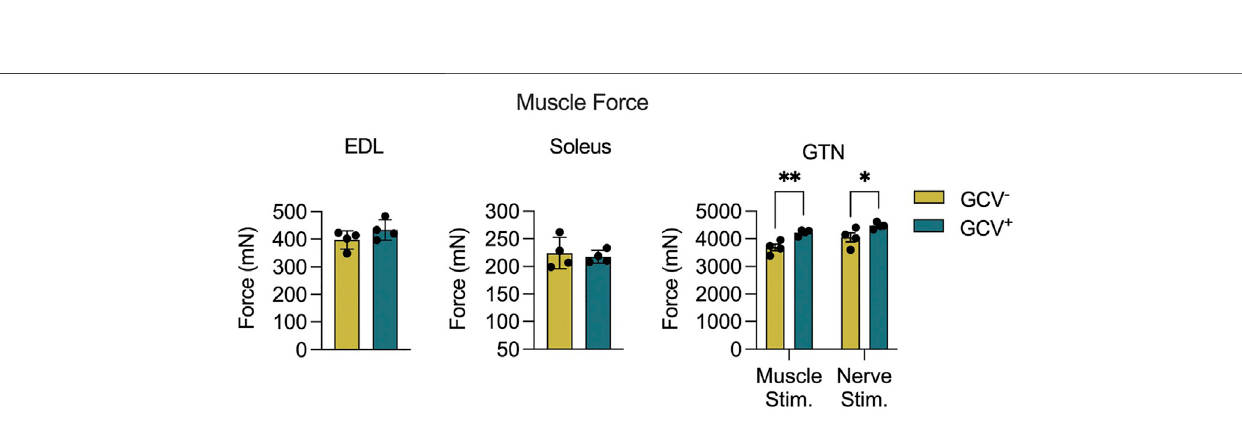
Frontiers in Aging |